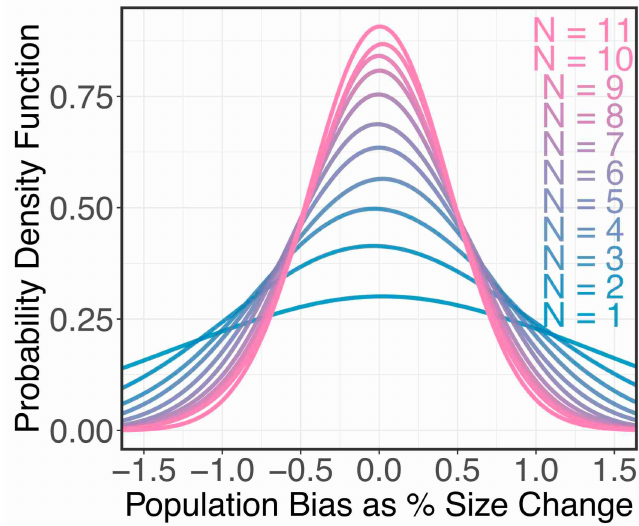
Figure 6. Simulated experiment. We simulated the experiment 10,000 times in Quest+ (bias = 0, detection threshold = 5%, lapse rate = 2%) to model how increasing the number of participants would improve the accuracy of our hierarchical Bayesian estimate of the true bias (true bias = 0). We determined that we needed n ≥ 5 to rule out an effect greater than our smallest effect size of interest (vergence size constancy >